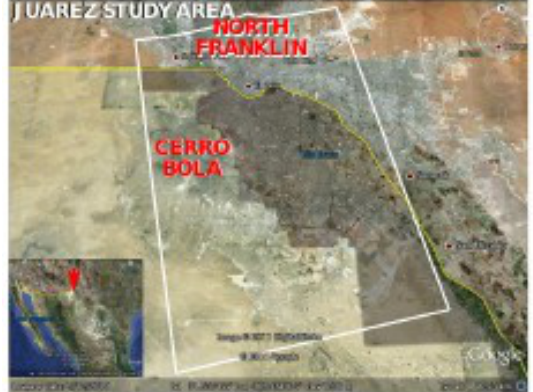
Figure 2 : Study area. North Franklin and Cerro Bola mountains are shown with red labels. The inset provides relative